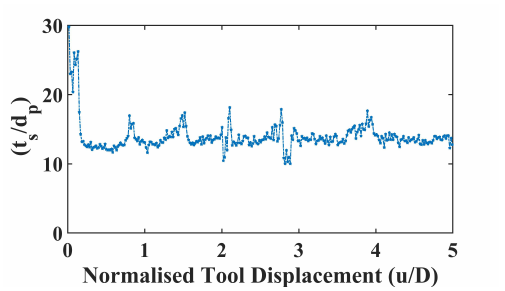
Figure 8. Evolution of shear band thickness, t s as a func- tion of tool displacement